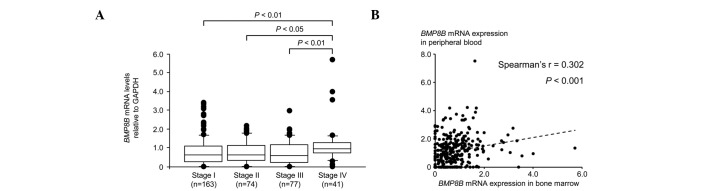
Expression levels of BMP8B mRNA in the bone marrow and peripheral blood of gastric cancer patients. (A) The expression levels of BMP8B mRNA in the bone marrow of 355 gastric cancer patients by TNM stage. The mRNA expression levels of BMP8B were normalized to those of GAPDH. The TNM stage was established based on the American Joint Committee on Cancer/International Union Against Cancer (AJCC/IUCC) staging system. Stage I, n=163; stage II, n= 4; stage III, n=77; and stage IV, n=41. P-values were estimated using the Mann-Whitney U test. (B) The correlation between BMP8B mRNA expression in 295 paired bone marrow and peripheral blood samples. A correlation coefficient (r) and the corresponding P-value for this correlation were estimated by Spearman’s correlation. BMP8B, bone morphogenic protein 8B; GAPDH, glyceraldehyde 3-phosphate dehydrogenase.